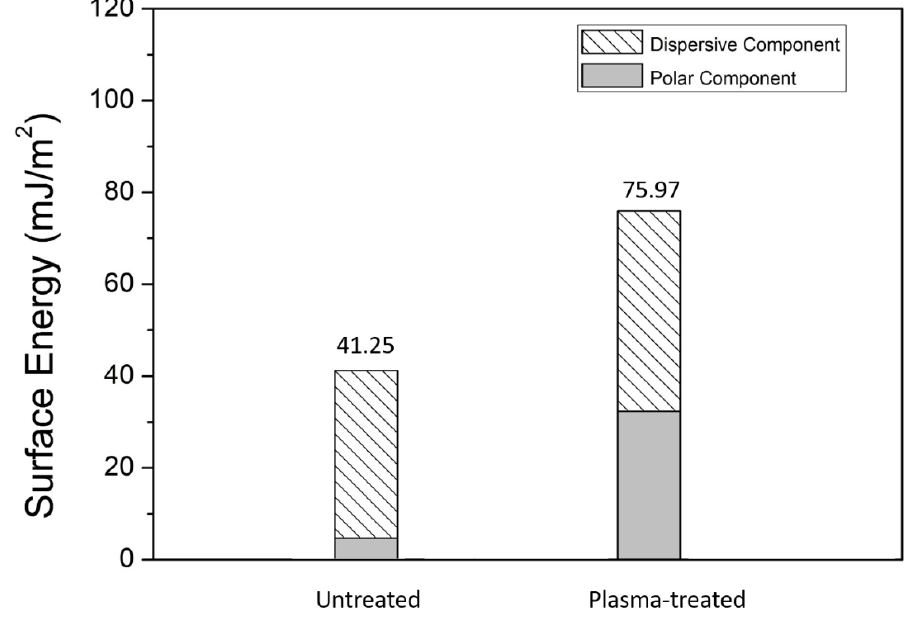
Figure 13. Surface energy of untreated and Ar-plasma treated Al surfaces.